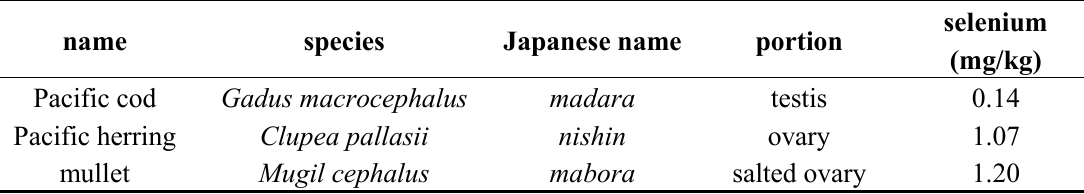
Table 2. Selenium content in the edible portions of